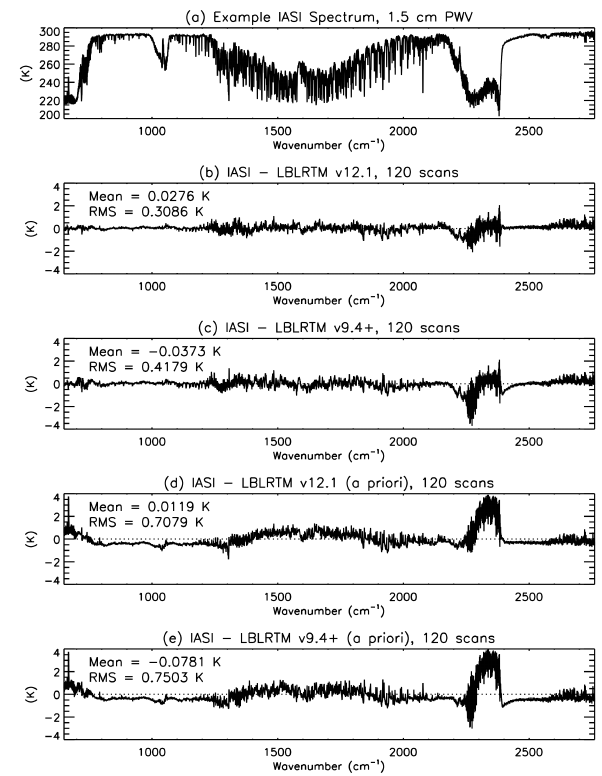
Fig. 2. (a) IASI-observed brightness temperature spectrum for an example profile with 1.5cm PWV. (b) Mean of the final (a posteriori) brightness temperature residuals for 120 spectra using LBLRTM v12.1. (c) Mean of the final brightness temperature resid- uals for 120 spectra using LBLRTM v9.4 + . (d) Mean of the a pri- ori brightness temperature residuals for 120 spectra using LBLRTM v12.1. (e) Mean of the final brightness temperature residuals for 120 spectra using LBLRTM v9.4 + . Note that the RMS due to instru- ment noise alone is